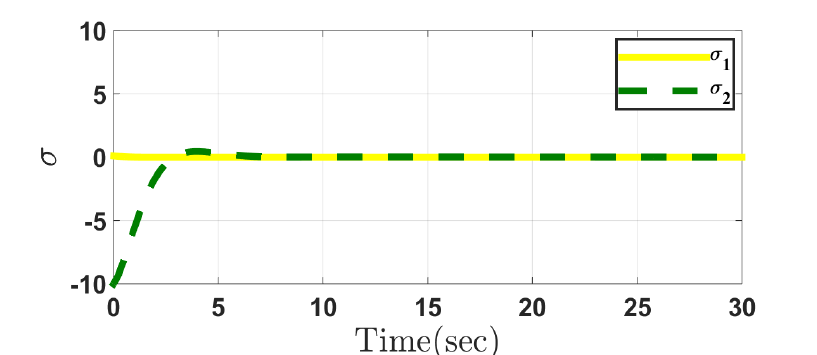
Figure 16. Sliding mode surfaces in the proposed method in Case 2.